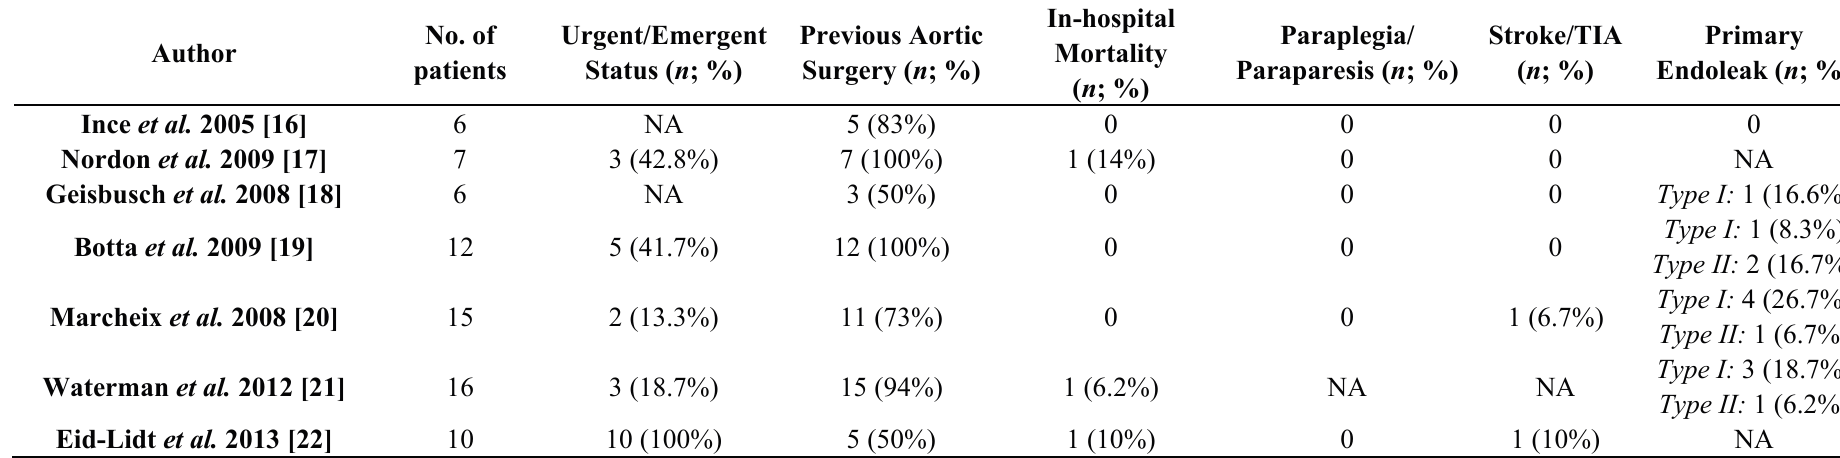
Table 1. Thoracic Endovascular Aortic Repair (TEVAR) in Marfan Syndrome: Preoperative status and early outcomes .